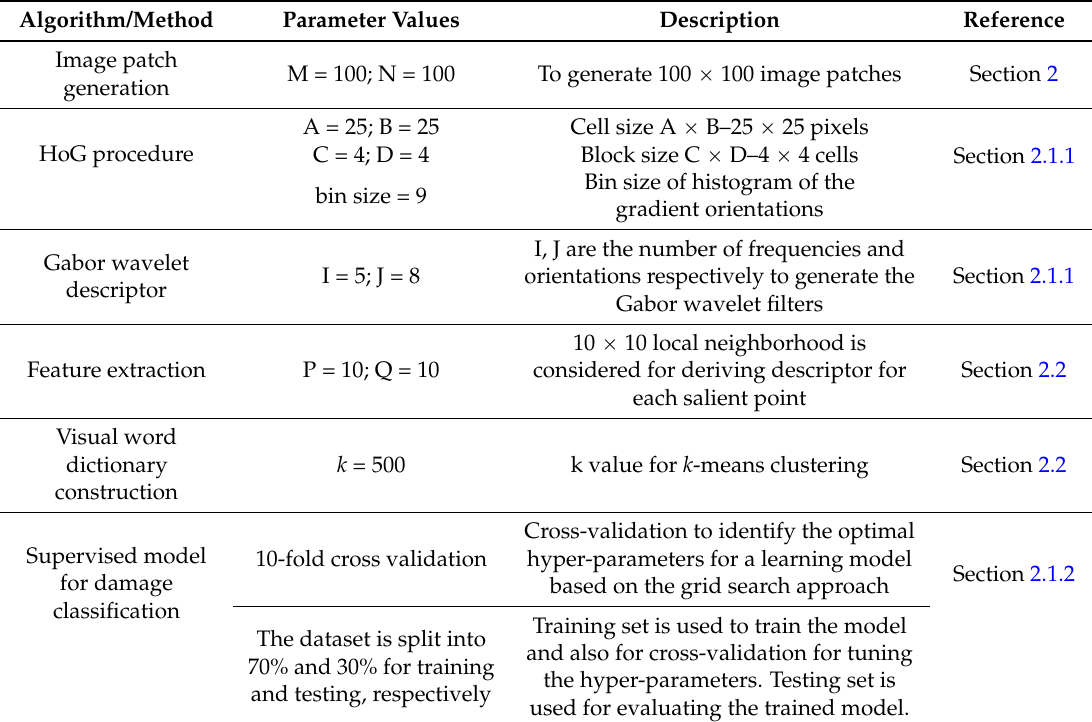
Figure 3. Combinations of feature descriptors and learning algorithms tested for each dataset. Table 1. Definition of parameters associated with each algorithm/method used in the experiment.